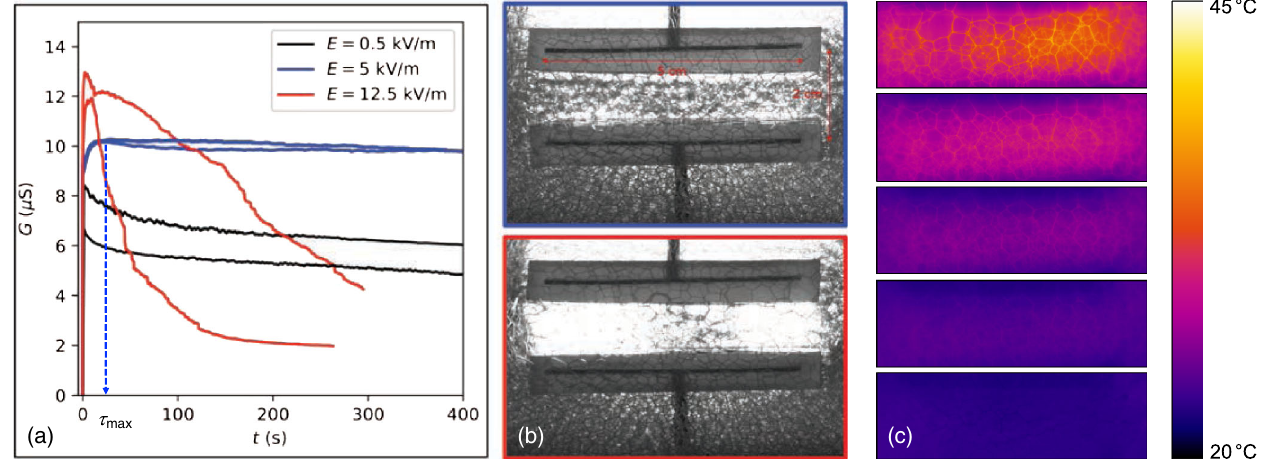
FIG. 2. (a) Conductance G of the foam as a function of time for different applied electric fields. In each case, two curves in the same 0 . 26% , L ¼ 20 mm. The time τ conditions are superimposed. R ¼ 4 . 3 mm, ϕ corresponds to the time at which the conductance i ¼ max 0 . 47% , L ¼ 20 mm. reaches a maximum. (b) Snapshots of foam for Δ V ¼ 100 V (top) and Δ V ¼ 500 V (bottom), R ¼ 2 . 6 mm, ϕ i ¼ (c) Infrared camera images of the foam for different applied voltages (from bottom to top: 200, 400, 600, 800, 1000 V). R ¼ 3 . 7 mm, ϕ 0 . 11% , L ¼ 29 mm. Image height corresponds to 22.6 i ¼